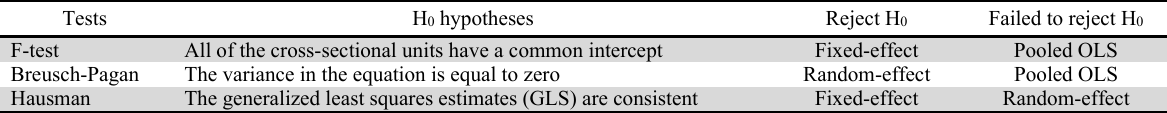
Tests to determine the best statistical